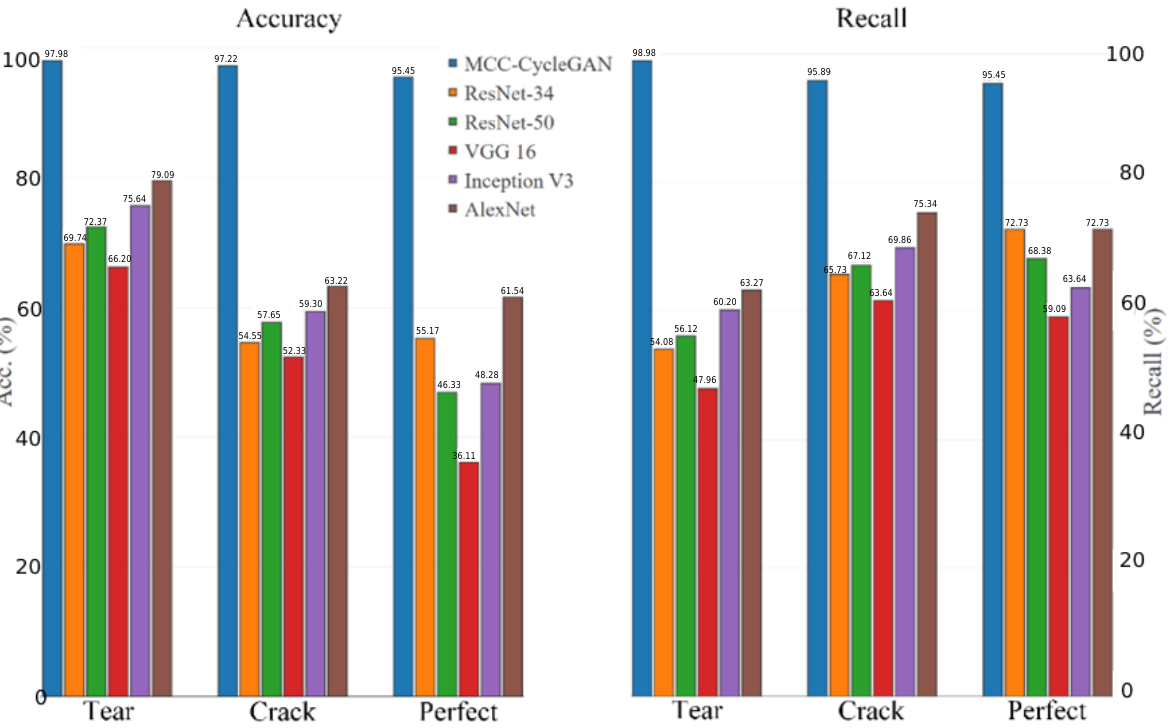
Figure 9. The results of the accuracies and recalls of all